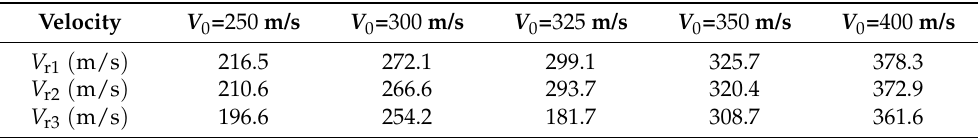
Table 8. Residual velocity after each perforation stage.